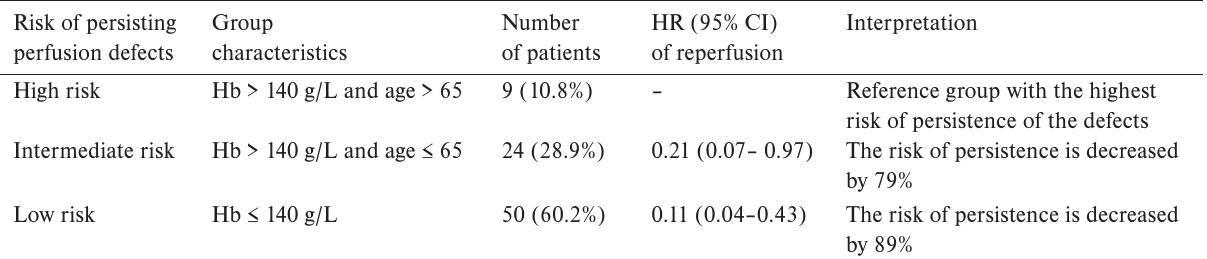
Table 3. Resulting Cox proportional-hazards model of reperfusion defects.